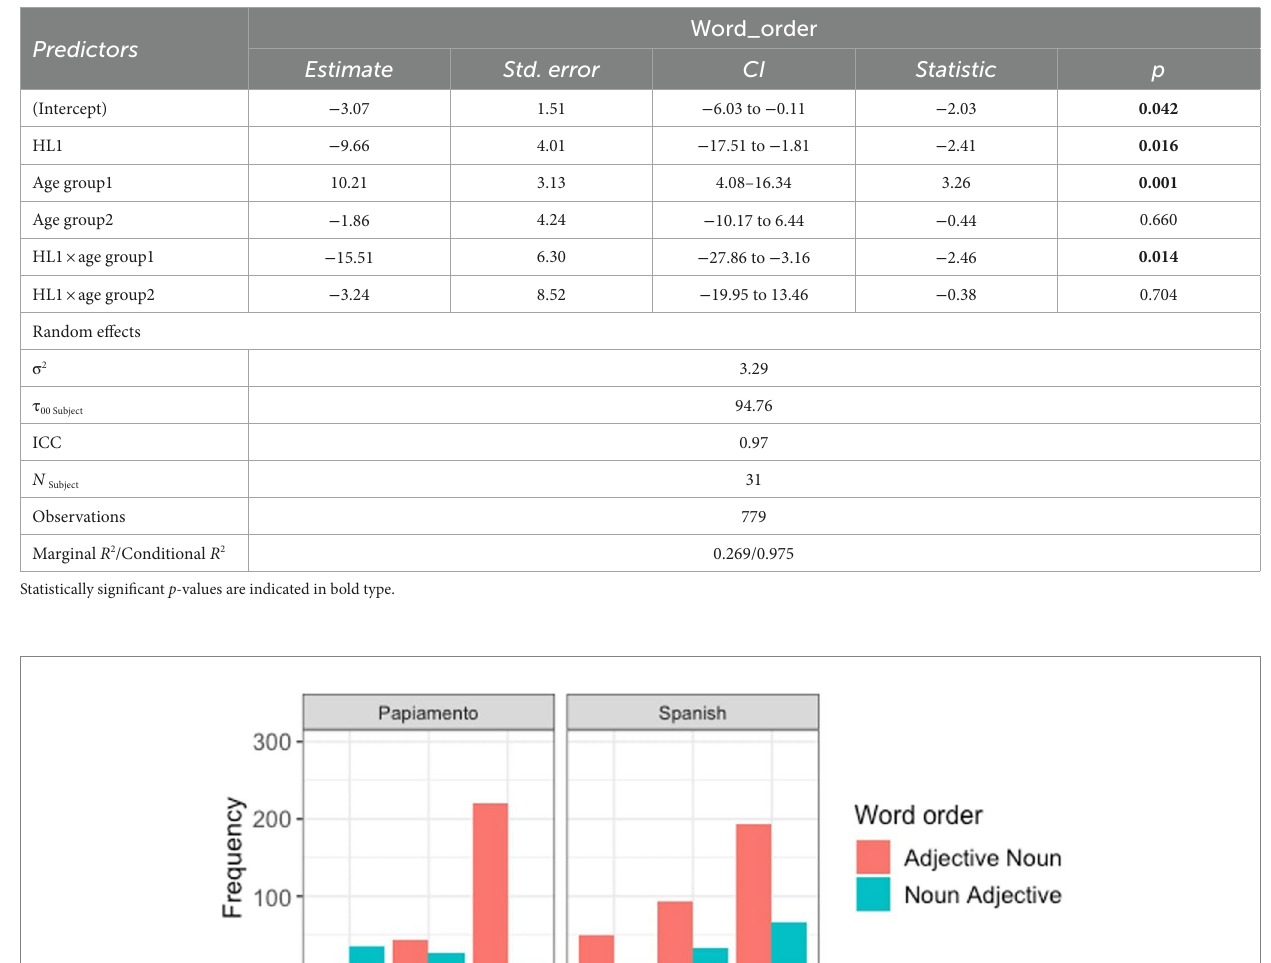
TABLE 7 Output for the final model containing extra-linguistic variables in Dutch mode with HL insertions.